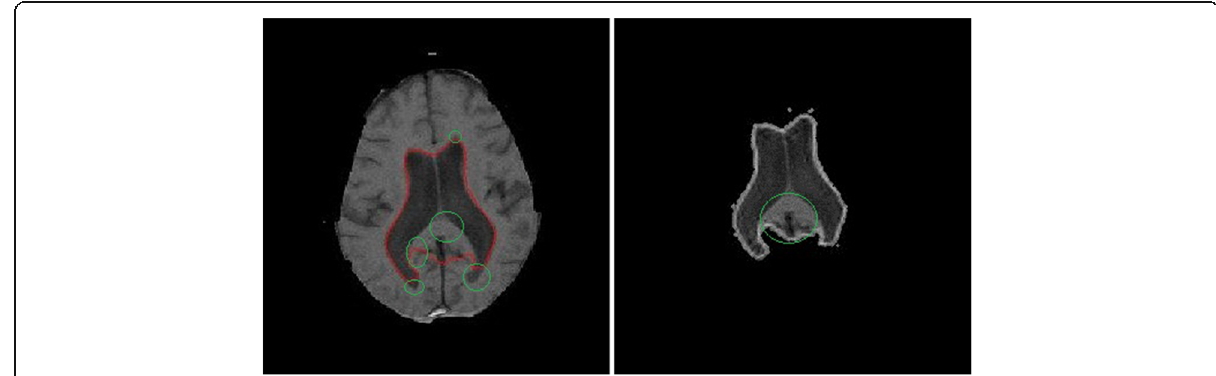
Fig. 2 Resultant images of segmentation using the conventional DRLSE method. The incorrect segmented regions are marked in green color circles